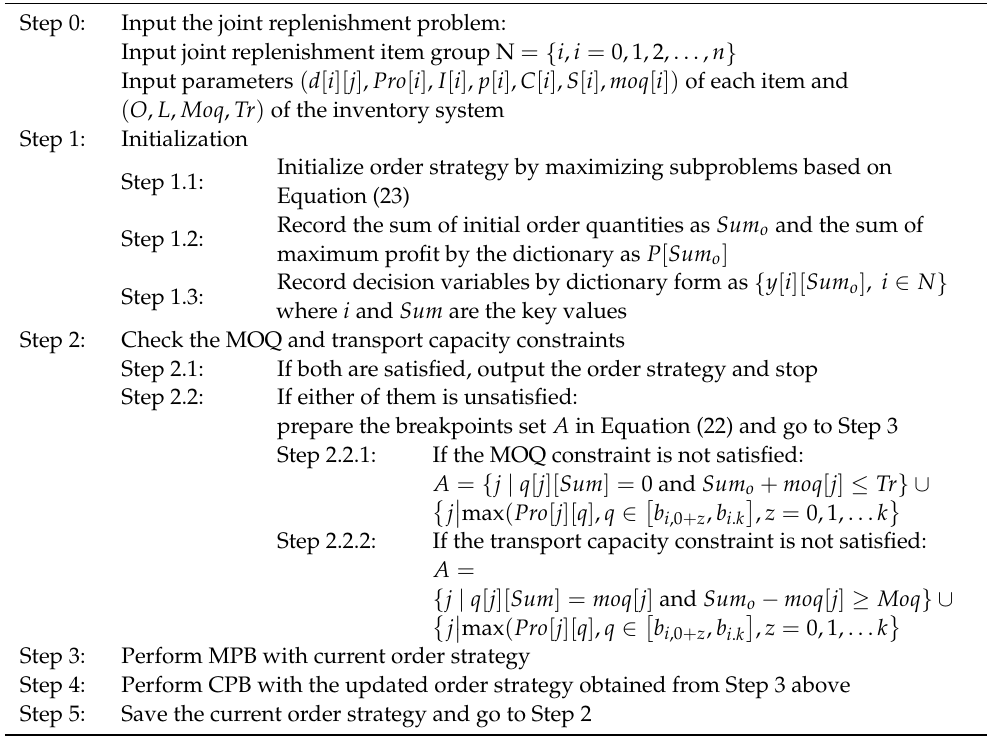
Algorithm 3. Process of Marginal Profit-Based and Cumulative Profit-Based Algorithm